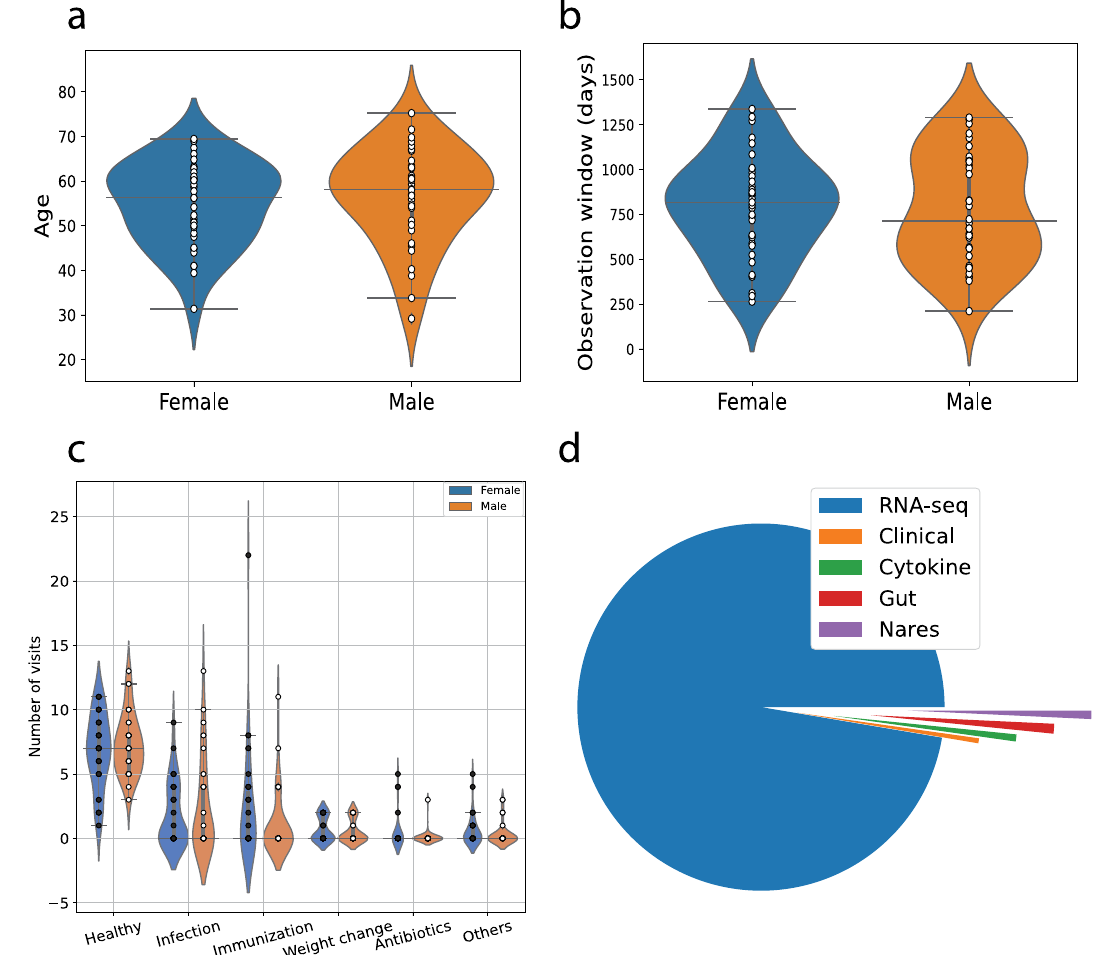
Figure 1. Cohort description. Summary distributions across sexes for ( a ) Age, ( b ) observation window, and ( c ) visits for different conditions. ( d ) Proportion of time series from different data